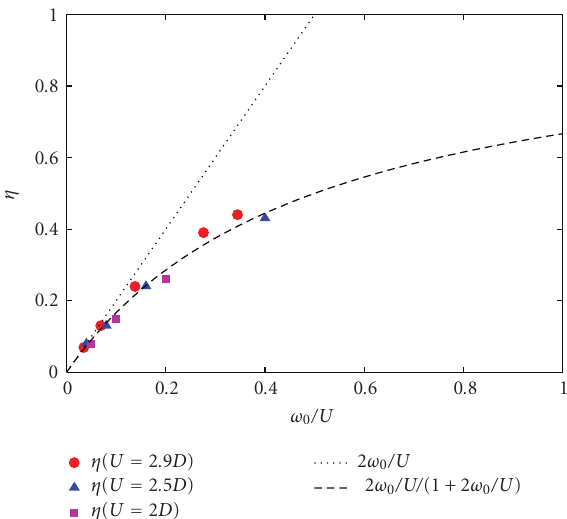
Figure 5: E ff ective static electron-electron interaction for the low- energy properties of the Hubbard-Holstein model. The picture shows the coe ffi cient η in U e ff = U − ηλW as a function of ω 0 /U (after Sangiovanni et al.